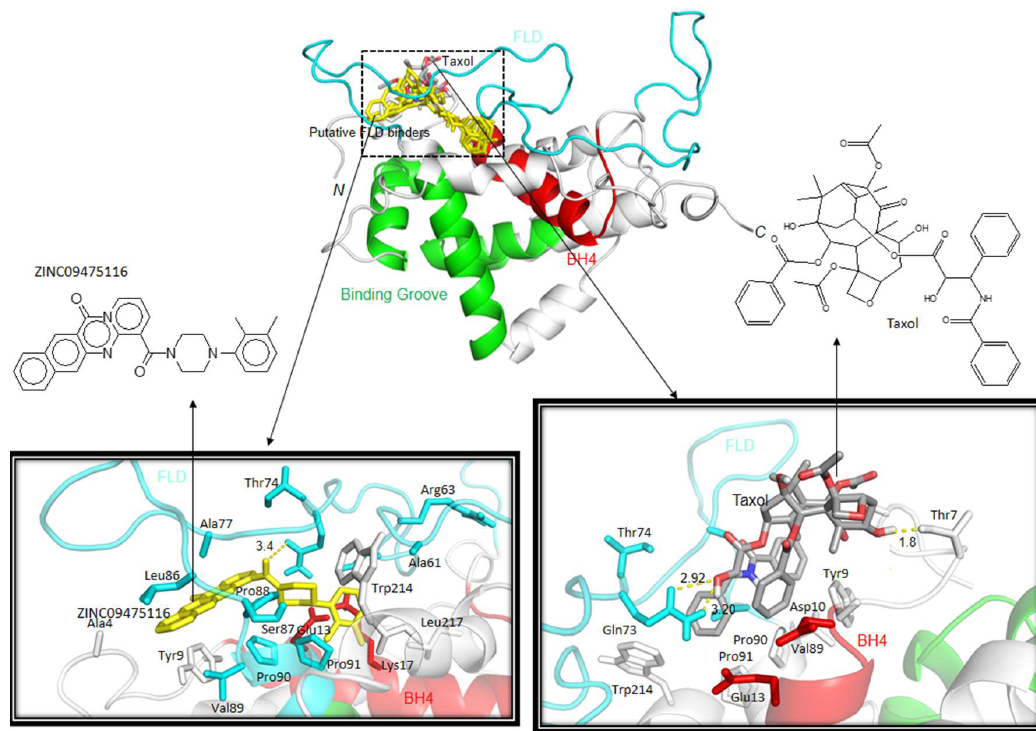
Figure 5. Docking orientations of putative inhibitors and Taxol with the physiological form of Bcl-2. Docking orientations were visualized by PyMOL Program [53]. Chemical scheme of Top1 putative inhibitor ZINC09475116 and Taxol are also presented. (Color codes: Cyan—FLD; Green—Binding groove formed by BH1, BH2 and BH3 domains; Red—BH4 domain).